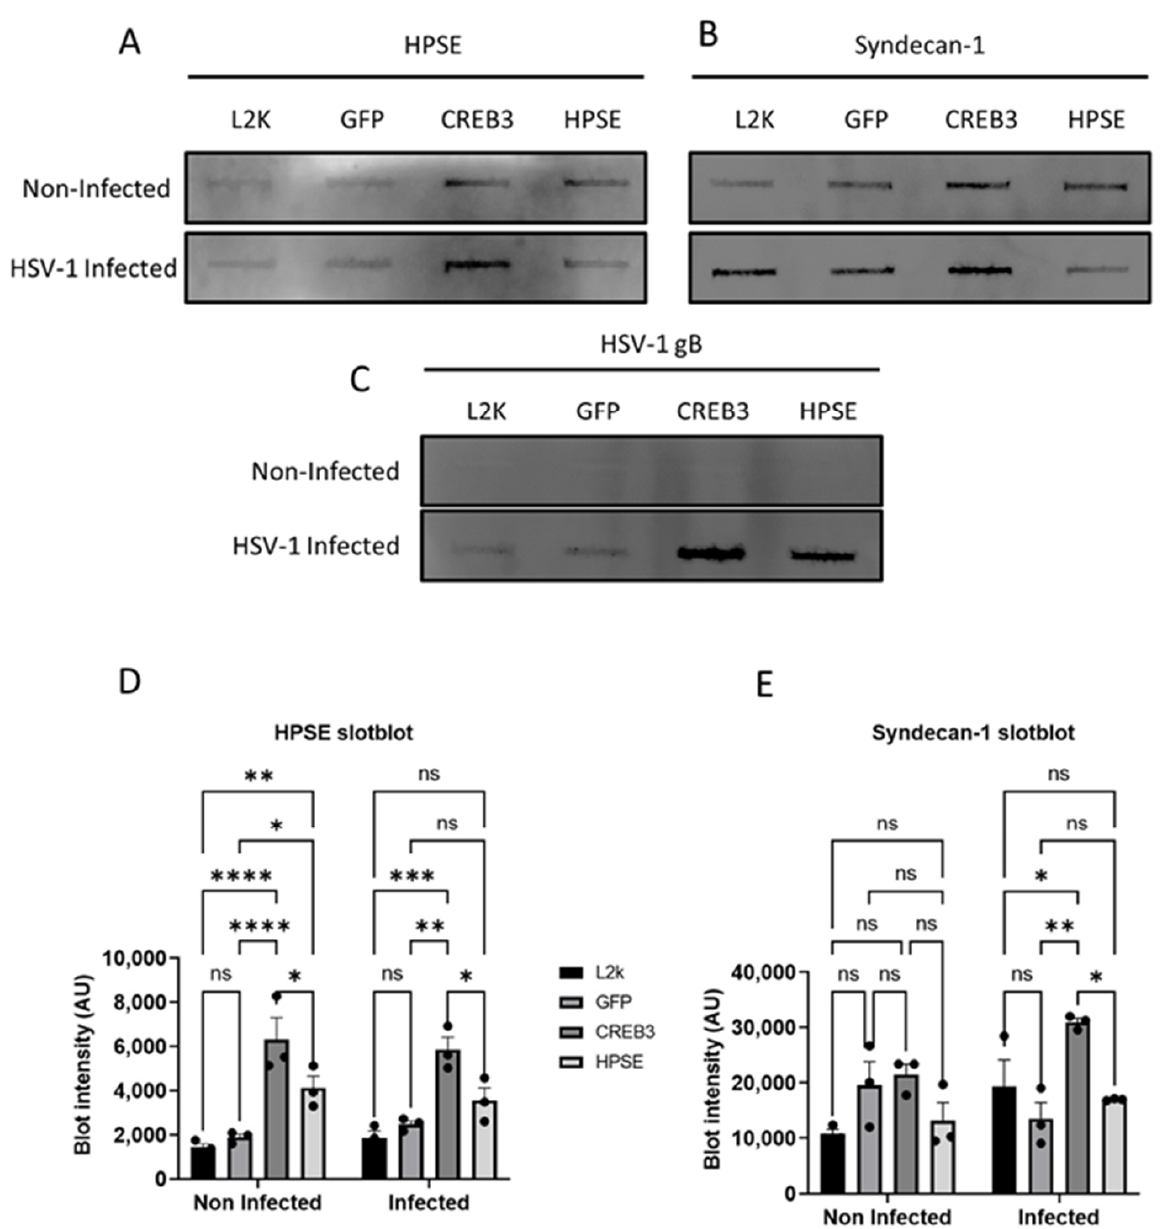
Figure 3. Upregulation of CREB3 increases extracellular HPSE: Human corneal epithelial cells were not transfected (lipofectamine only—L2K) or transfected with a control plasmid, CREB3 plasmid, or full-length HPSE plasmid for 48 h with or without HSV-1 infection. Cellular supernatants were collected and analyzed via a slot blot technique. ( A ) HPSE secretion, ( B ) Syndecan-1 secretion, and ( C ) HSV-1 envelope glycoprotein-B secretion were detected using the slot blot technique. ( D , E ) Ex- periments mentioned in ( A , B ) were performed in triplicate and the quantification of the slot blot bands was performed using image J and represented as bar charts. * p -value < 0.05, ** p < 0.01, *** p < 0.001, **** p < 0.0001.